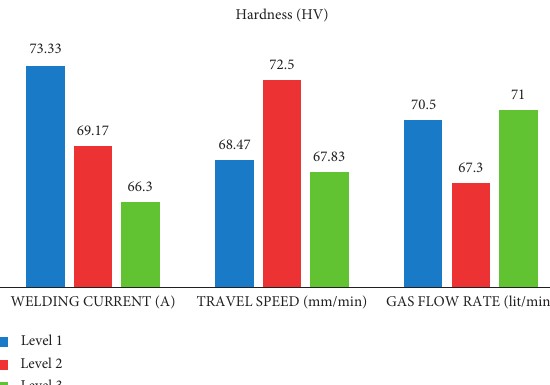
Figure 6: Effect of welding parameters over hardness.